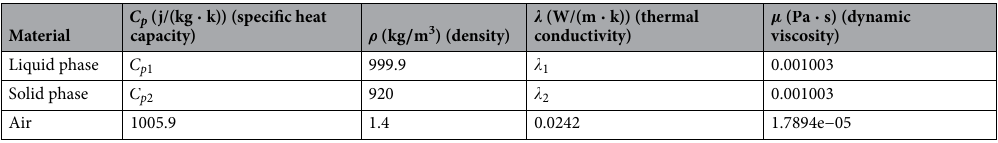
Table 4. Physical properties of droplets and air.